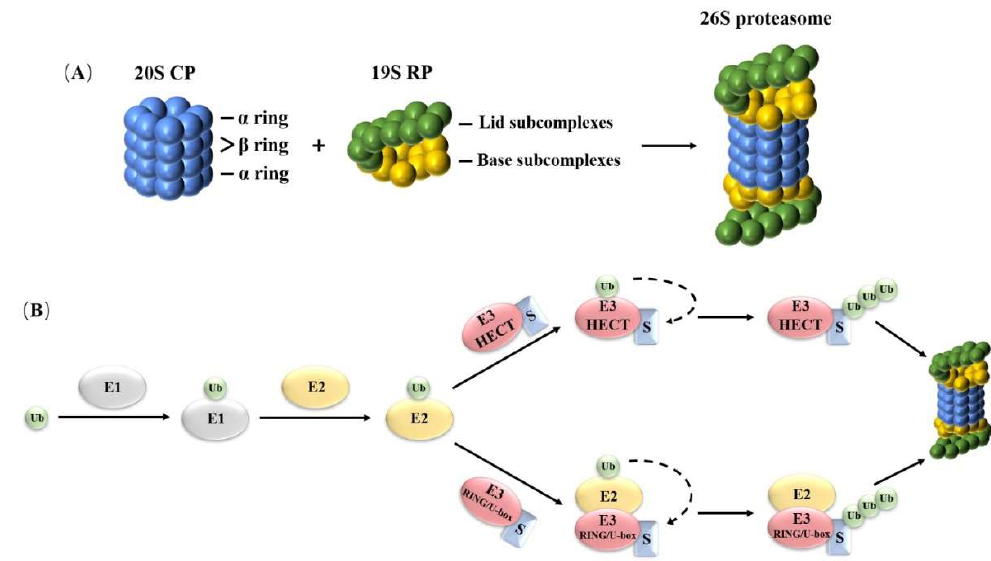
Figure 1. Structure of the 26S proteasome and the ubiquitin pathway. ( A ) 20S CP (20S Core Particle); 19S RP (19S Regulatory Particle). ( B ) Ubiquitination pathway. Ub, ubiquitin; E1, ubiquitin-activating enzyme; E2, ubiquitin-conjugating enzyme; E3 HECT, ubiquitin ligase enzyme with homologous to E6-associated protein C-terminus domain; E3 RING/U-box, ubiquitin ligase enzyme with really interesting new gene/U-box domain; S, substrate protein.